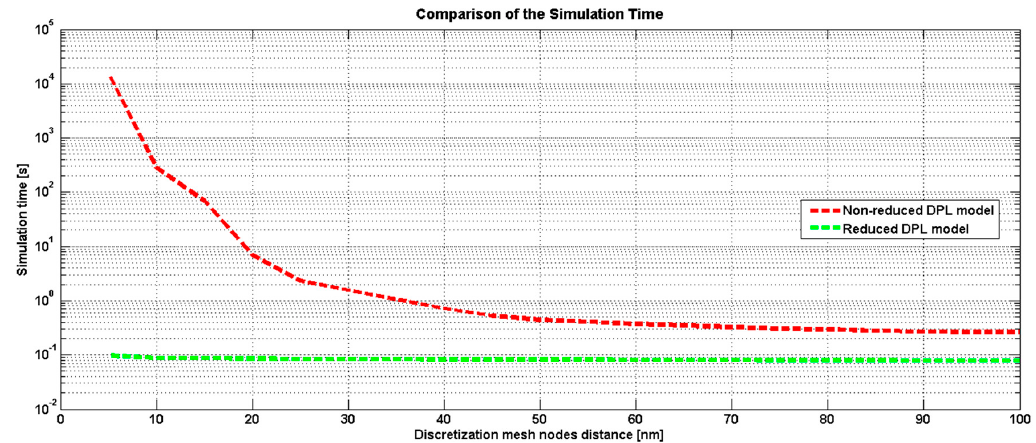
Figure 8. Comparison of simulation time consumed during solution calculation in relation to discretization mesh nodes distance based on non-reduced and reduced DPL models .